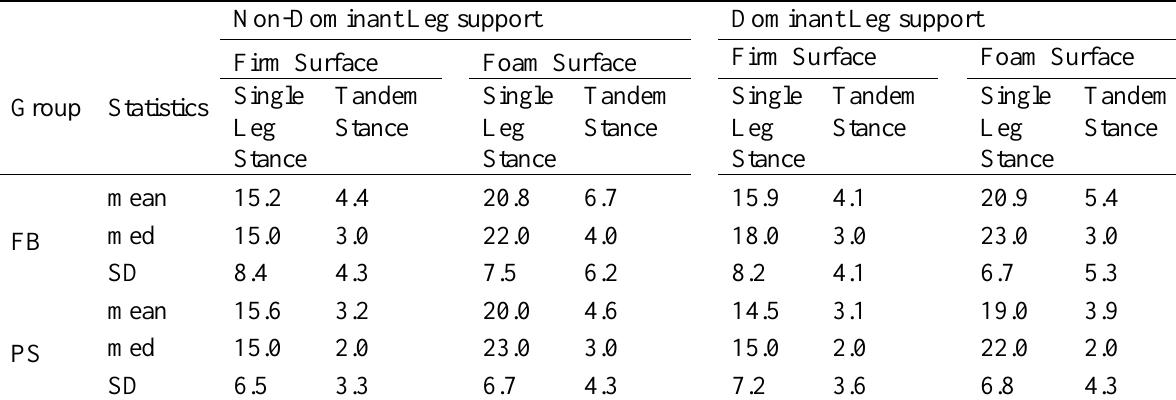
med = Median, SD = Standard Deviation, FB = Full blind, PS = Partially